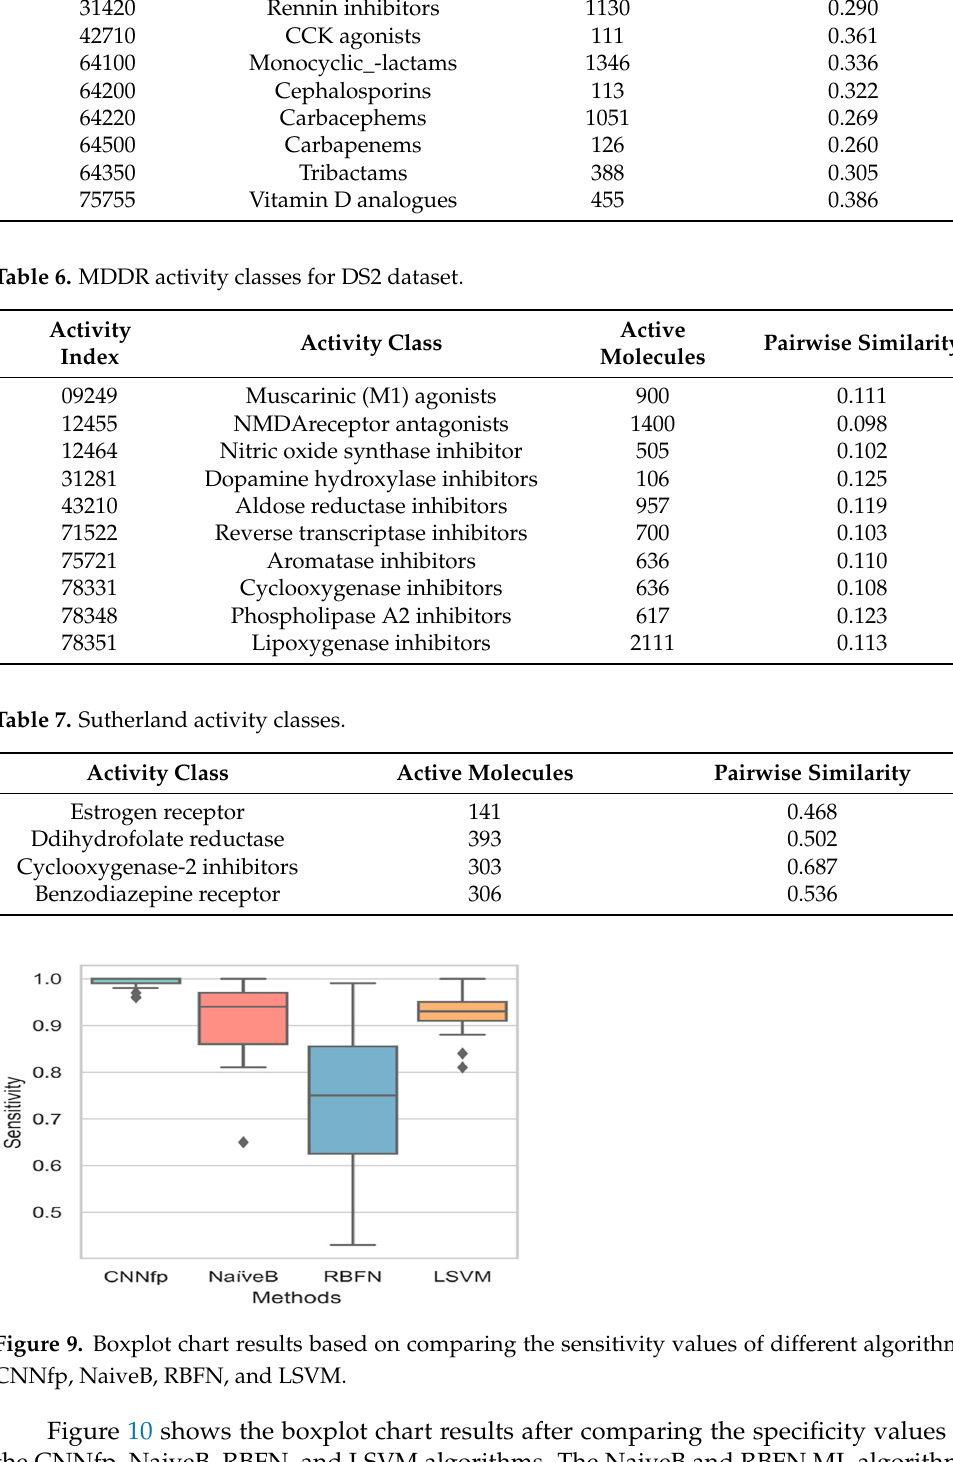
Figure 10. Boxplot chart results based on comparing the specificity values of different algorithms: CNNfp, NaiveB, RBFN, and LSVM. Figure 11 describes the Boxplot chart results after comparing the AUC values of the CNNfp, NaiveB, RBFN, and LSVM algorithms. The LSVM, NaiveB, and RBFN ML algo- rithms showed a higher variance of 0.125, 0.083, and 0.033, respectively, compared to CNNfp. This diversity in all AUC values was especially seen in the algorithms that dis- played a variance of 4.13 × 10 − 5 . A combination of the Mol2mat with the CNNfp algorithm showed an AUC value of 0.99, whereas the LSVM, NaiveB, and RBFN algorithms dis- played higher average AUC values of 0.96, 0.99, and 0.85, respectively. The results showed a p -value of 4.2 × 10 − 3 , highlighting a significant difference between all algorithms.